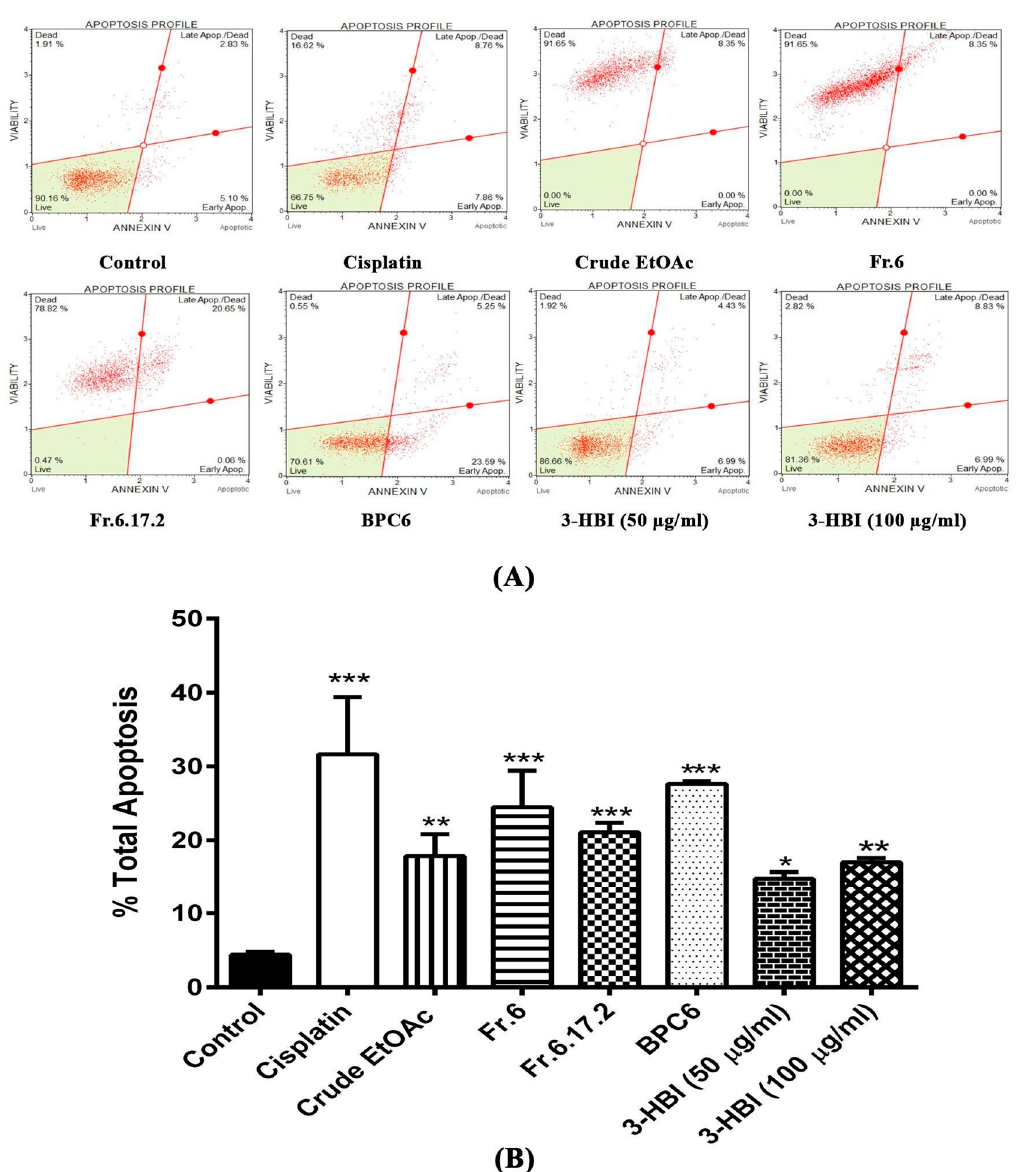
Figure 4. Determination of apoptosis in SCC15 cell line after treatment with MO extract, fraction no. 6, sub-fraction no. 6.17.2 BPC6, and 3-HBI for 24 h. ( A ) Dot plots of annexin V and 7-AAD dual staining showing the percentage of cell populations in each of the four quadrants. ( B ) Bar graphs showing quantitative data of percentage of total apoptotic cells. Results are presented as means ± SEM. * p ≤ 0.05, ** p ≤ 0.01, and *** p ≤ 0.001 compared to control. Control: untreated SCC15; crude EtOAc: crude ethyl acetate; Fr.6: fraction no. 6; Fr.6.17.2: sub-fraction no. 6.17.2; BPC6: base peak chromatogram no. 6; 3-HBI: 3-hydroxy- β -ionone.